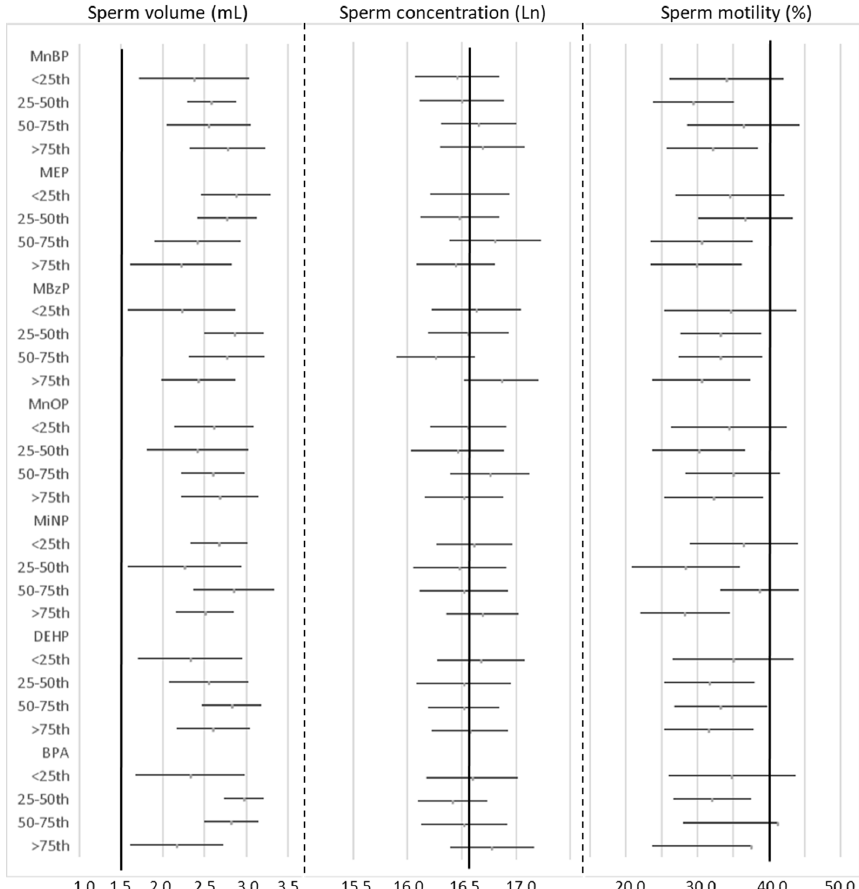
Figure 1. Average estimates and 95% confidence intervals of semen parameters in relationship with natural logarithm of metabolites concentration, from adjusted regression models, compared with the WHO reference values (1.5 mL for volume; 16.52 for Ln of sperm concentration; 40% for motility) represented by the vertical black lines.